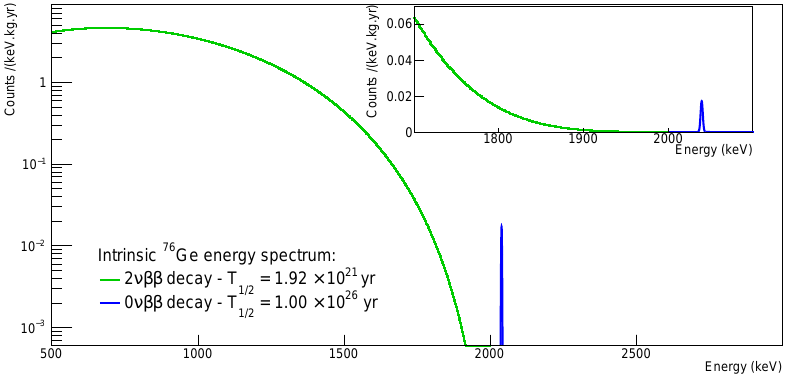
Figure 3. Schematic view of the expected 0 νββ and 2 νββ decay spectra. Credits to G ERDA